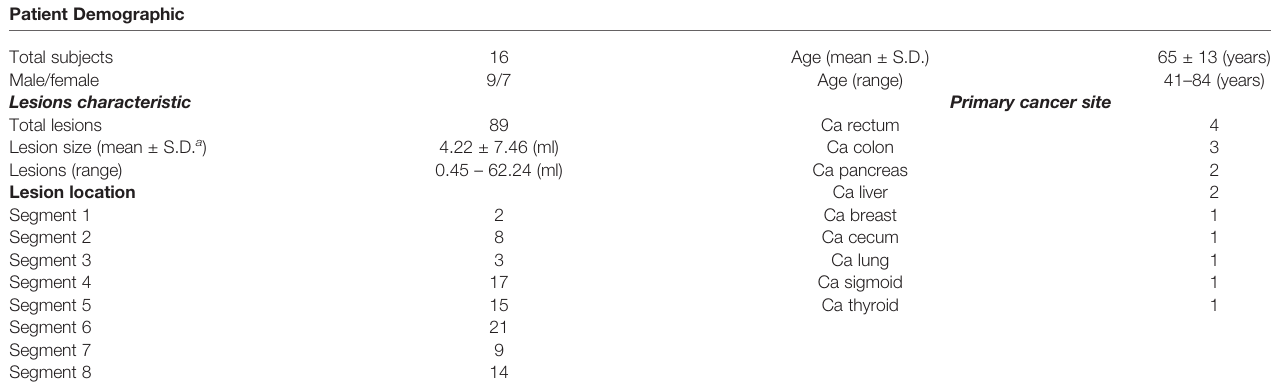
TABLE 1 | The patient demographic and lesion characteristics.